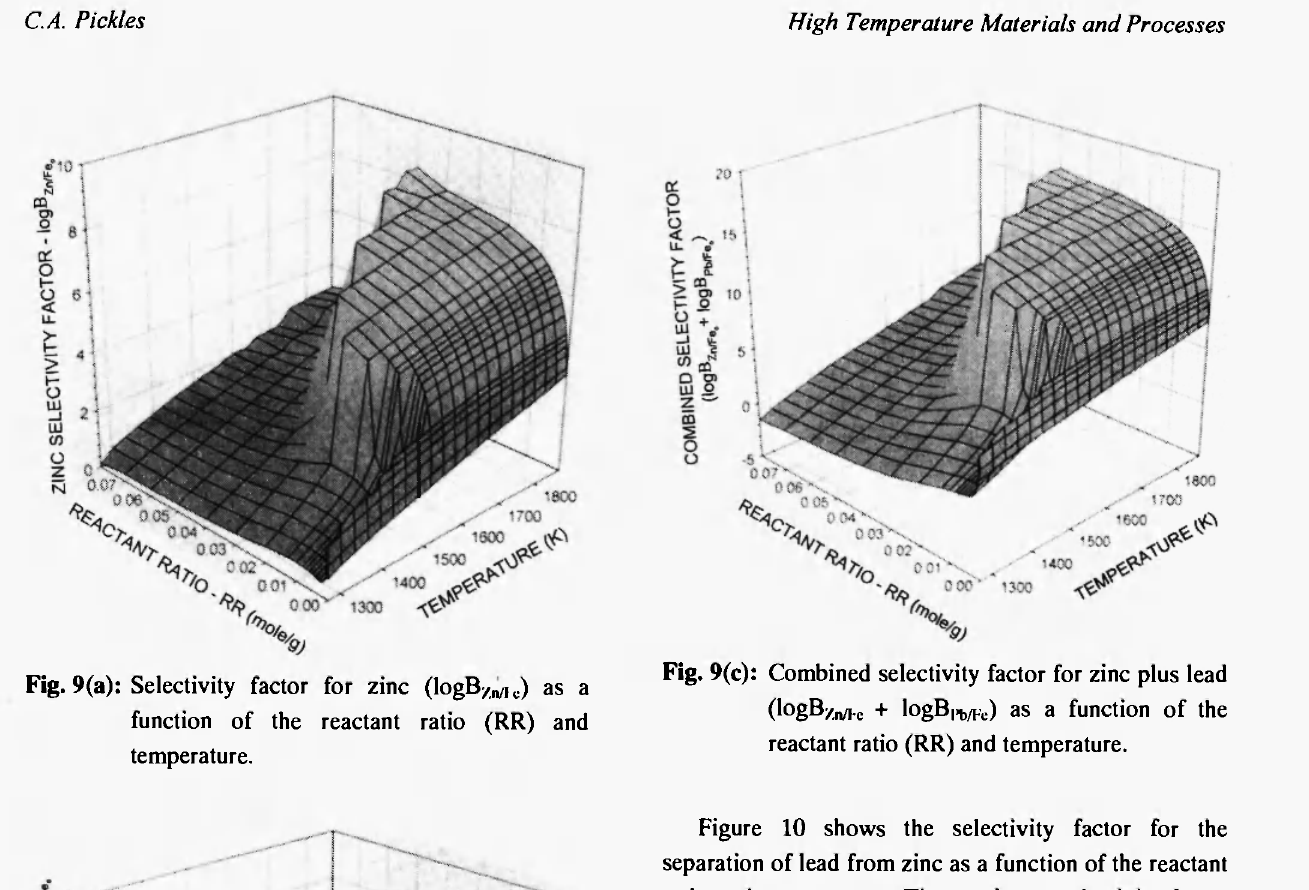
Fig. 9(a): Selectivity factor for zinc (logB /n/Ic ) as a function of the reactant ratio (RR) and temperature.